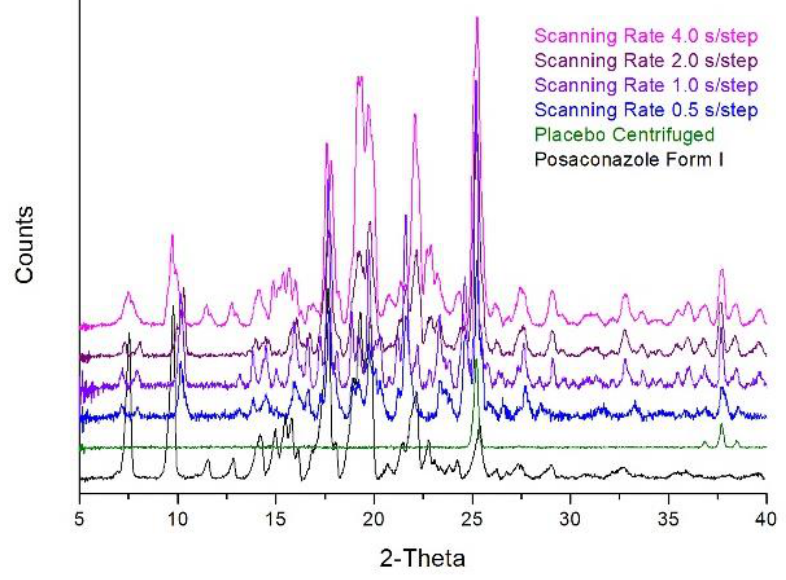
Figure 3. Setting the scanning rate of the XRPD analysis of the oral suspension ′ s precipitate: XRPD patterns of Posaconazole Form I ( black line ), precipitate of Posaconazole oral suspension ′ s placebo after centrifugation ( green line ) and precipitate of Posaconazole oral suspension after centrifugation recorded with scanning rate of 0.5 s/step ( blue line ), 1.0 s/step ( violet line ), 2.0 s/step ( purple line ) and 4.0 s/step ( magenta line ).